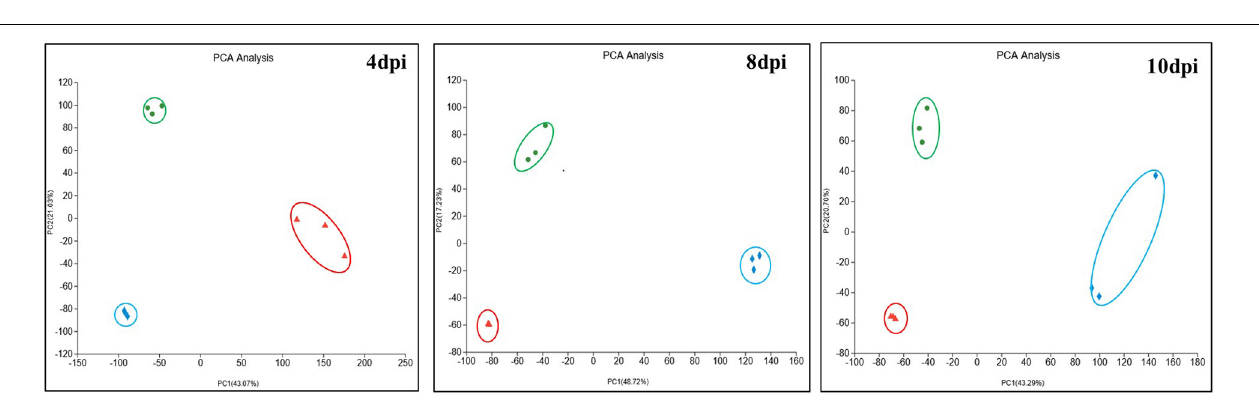
FIGURE 1 | The OD 600 value and the coronatine production of DC3000 under different FeCl 3 concentration fermentation conditions. (A) The OD 600 values of the three groups researched in the study were detected by ultraviolet spectrophotometer at OD 600 after inoculation in fermentation medium. (B) The coronatine production of the three groups was measured at 10 days after inoculation in fermentation when the yield of the fermentation culture was stable. The mean was taken from three biologically independent replicates.